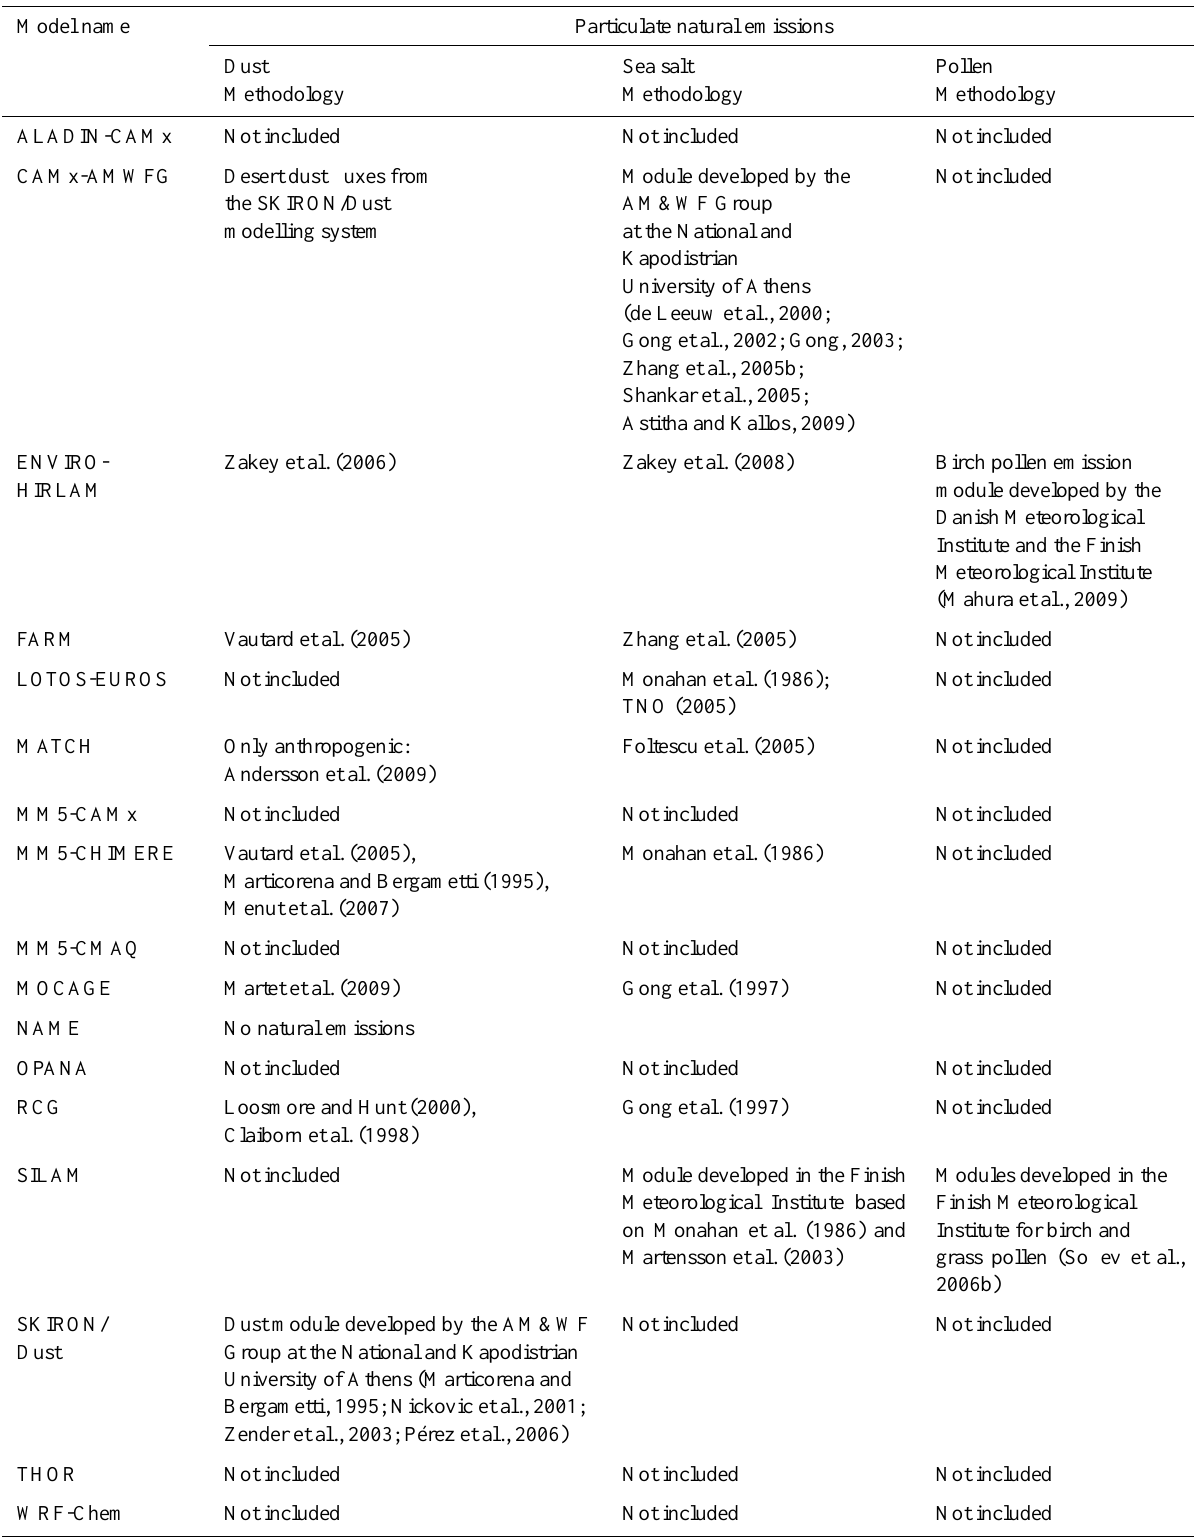
Table 8b. The particulate emissions accounted for in the CWF models, as well as their calculation